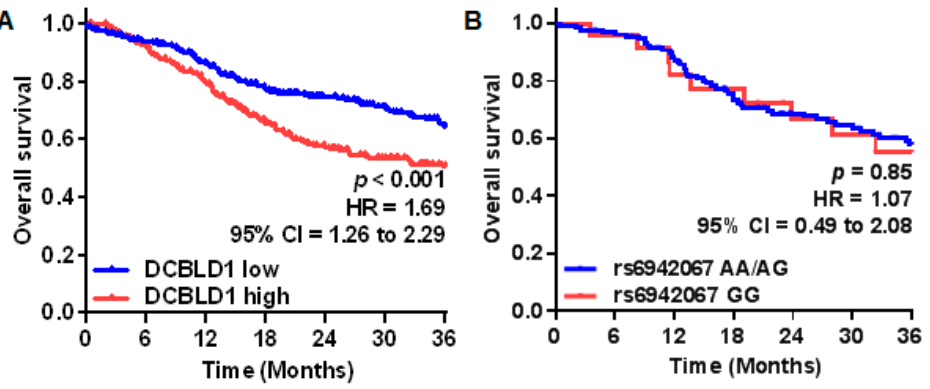
Figure 3. DCBLD1 gene expression, rs6942067, and HNSCC overall survival comparison for HNSCC patients of the TCGA cohort using the Kaplan–Meier curve estimation for ( A ) tumor low (blue, n = 258) and high (red, n = 259) DCBLD1 gene expression; and for ( B ) rs6942067 AA and AG (blue, n = 131) versus rs6942067 GG (red, n = 23). p values were calculated using a two-sided log-rank test. Table 2. Clinical features of the TCGA HNSCC cohort stratified by DCBLD1 gene expression.